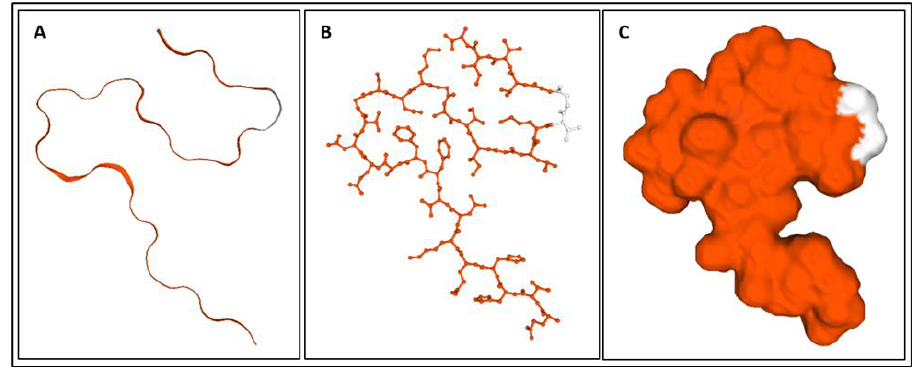
Figure 8. ( A ) A cartoon model, ( B ) a ball-and-stick model, and ( C ) a surface model of Aβ42 made using amino acid sequences from the GenScript website [36].